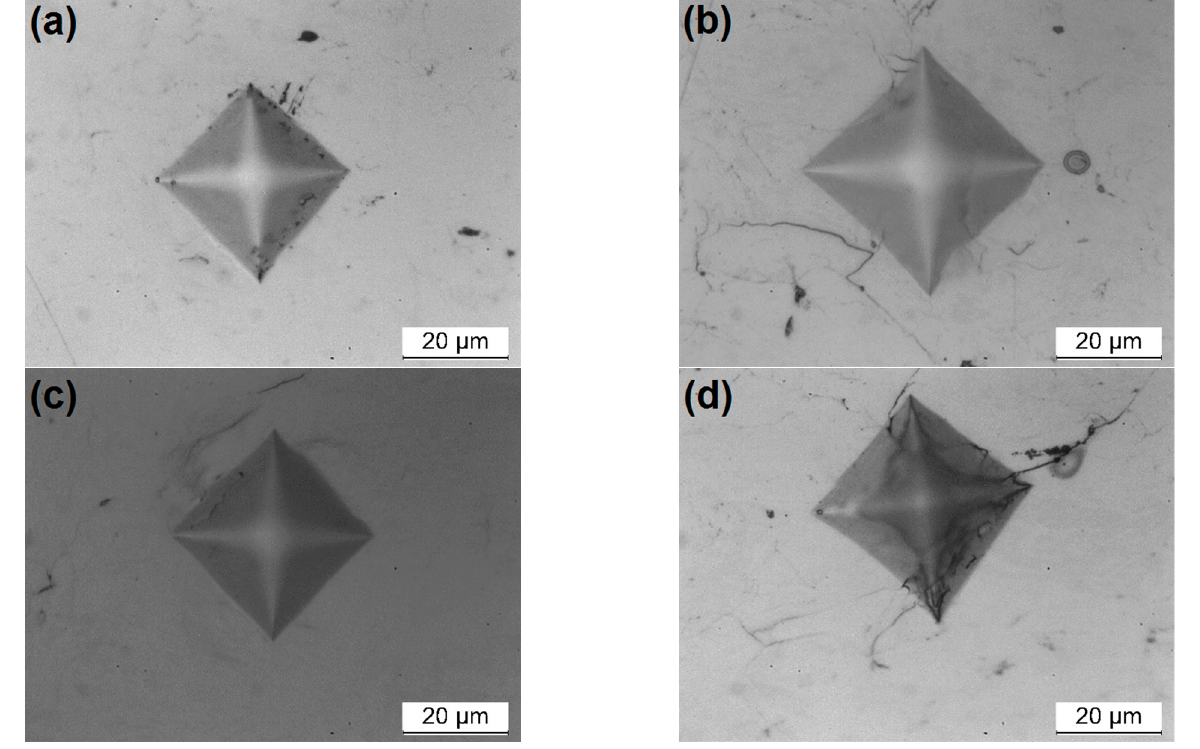
Figure 7. Marks for hardness measurements of the coatings. ( a ) 316L-CGS_1, ( b ) 316L-CGS_2, ( c ) 316L-HVOF, and ( d ) 316L-APS.